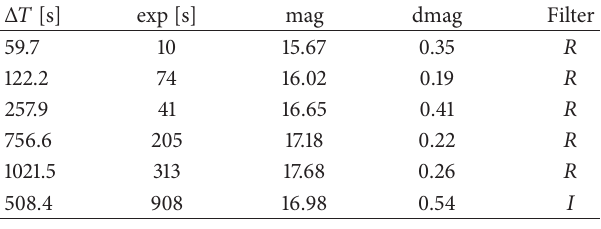
Table 6: GRB 051109A: observing log of BOOTES-1B.